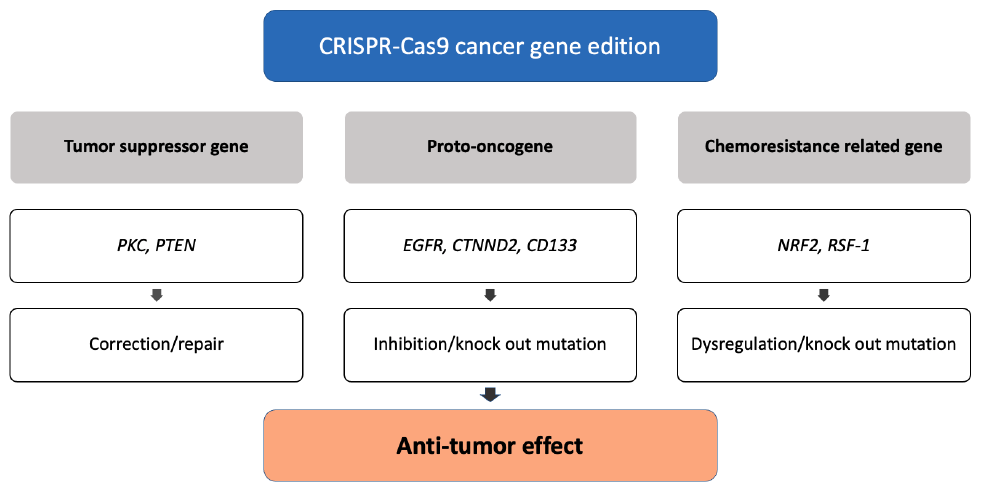
Figure 1. The mechanism of antitumor effect with CRISPR-Cas9 gene